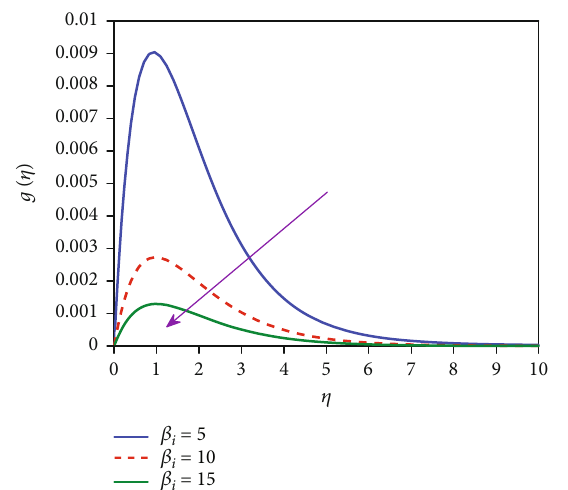
Figure 15: E ff ect of β